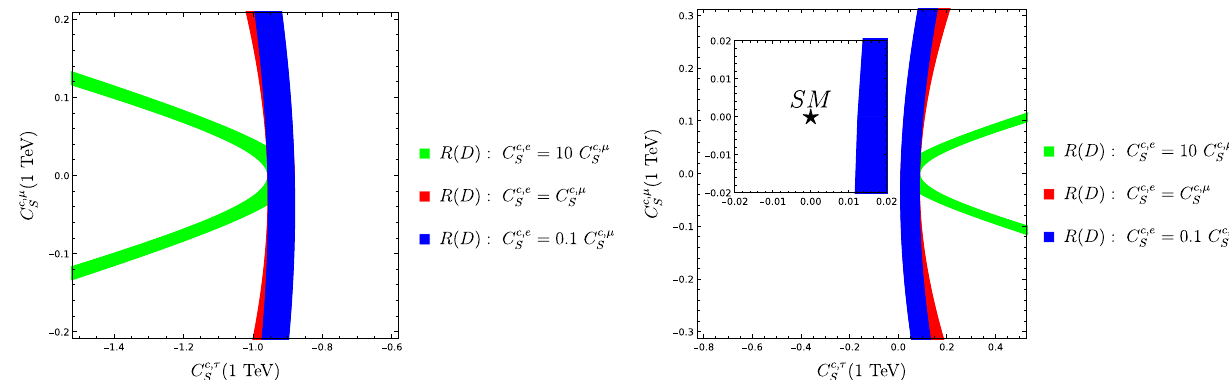
μ – C plane considering different correlations between C e S S